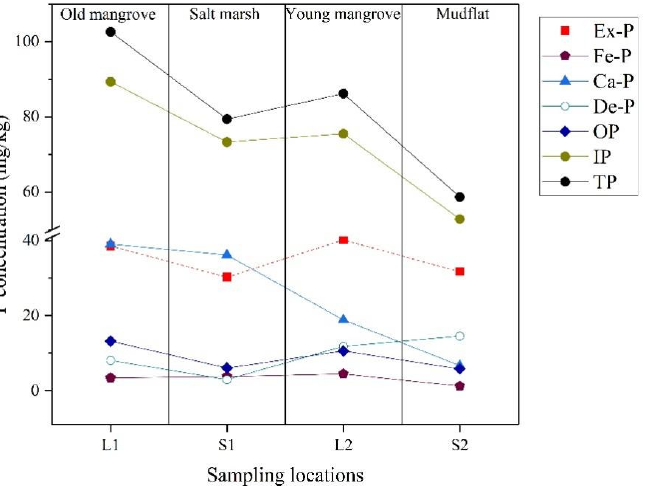
(Figure 3). The BAP concentration was rather constant along L1 below the 40 cm layers, showed the highest concentrations at approximately 25–40 cm, and then decreased toward the surface sediments. The BAP concentration remained constant throughout S1, except for the drastic decrease in the surface sediment. It exhibited a decreasing trend from the bottom to the surface layer of L2 and showed a decreasing trend from 36 cm toward the surface sediment along the core S2 (Figure 4).